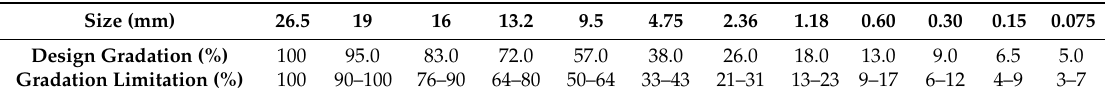
Table 5. Gradation of